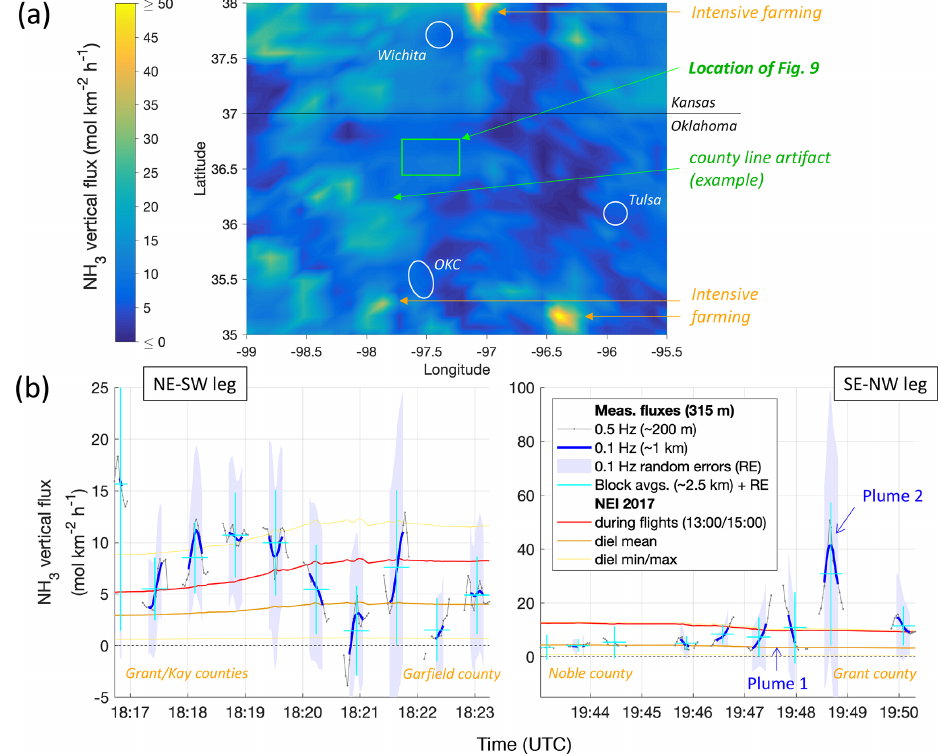
Figure 11. (a) Map of the NEI for area emissions of NH 3 for 14 May at 19:00UTC (14:00 local time, LT), using the same color scale as in Fig. 10. The geographic location of Fig. 10 is highlighted in green, and an example of artifacts caused by county lines (details in text) is pointed out. Major towns are indicated in white for reference (OKC = Oklahoma City). (b) Time series of quality-controlled measurement- derived fluxes ( F CWT ) during the low-level legs of RF13 (gray and blues) are shown compared to the emissions in the NEI at the locations of the IQR of the respective footprints (as shown in Fig. 10). NEI values for 18:00UTC (left, 13:00LT) and 20:00UTC (right, 15:00LT) are shown in red, diel mean values are shown in brown, and the diel minimum and maximum are shown in yellow. Measured fluxes at 0.5Hz ( ∼ 200m spatial resolution), as used for Fig. 10, are shown in gray; moving averages to 0.1Hz ( ∼ 1km) are shown in blue, with shadings representing their random errors (RE wave ). Cyan crosses indicate block-wise (mostly ∼ 2.5km wide) flux averages and respective RE wave values. The times of transecting plume 1 and plume 2 (see text and Fig. 12) are marked by